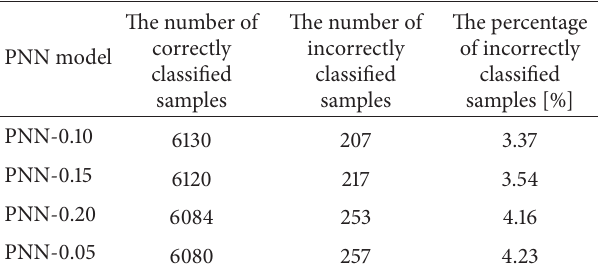
Table 2: Testing results for four 𝑖 PNN with lowest percentage of incorrectly classified samples.